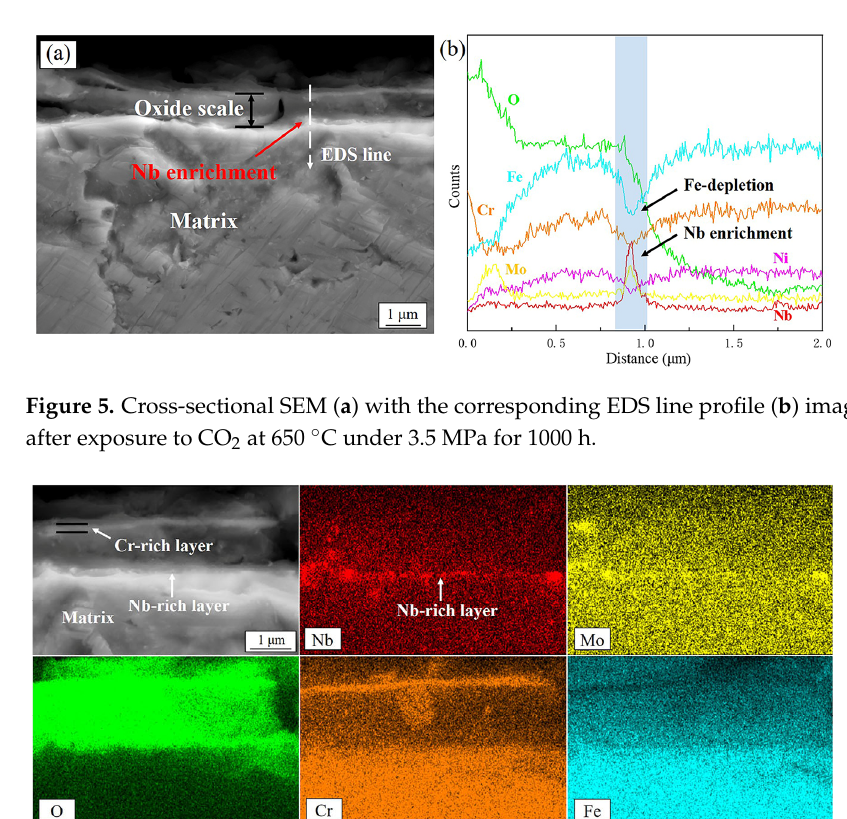
Figure 7. Cross-sectional SEM ( a ) with the corresponding EDS line pro fi le ( b ) images of sample S2 after exposure to CO 2 at 650 °C under 3.5 MPa for 1000 h.